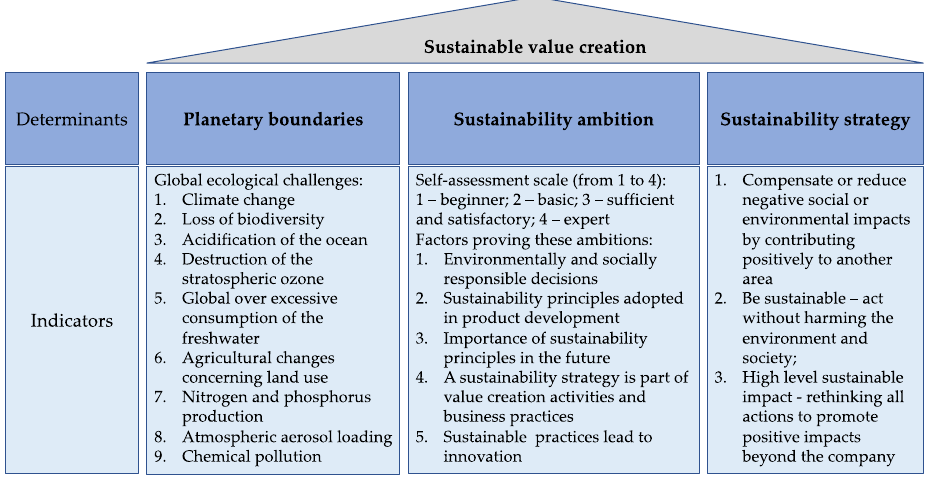
Figure 2. Determinants of sustainable value creation (source: authors).